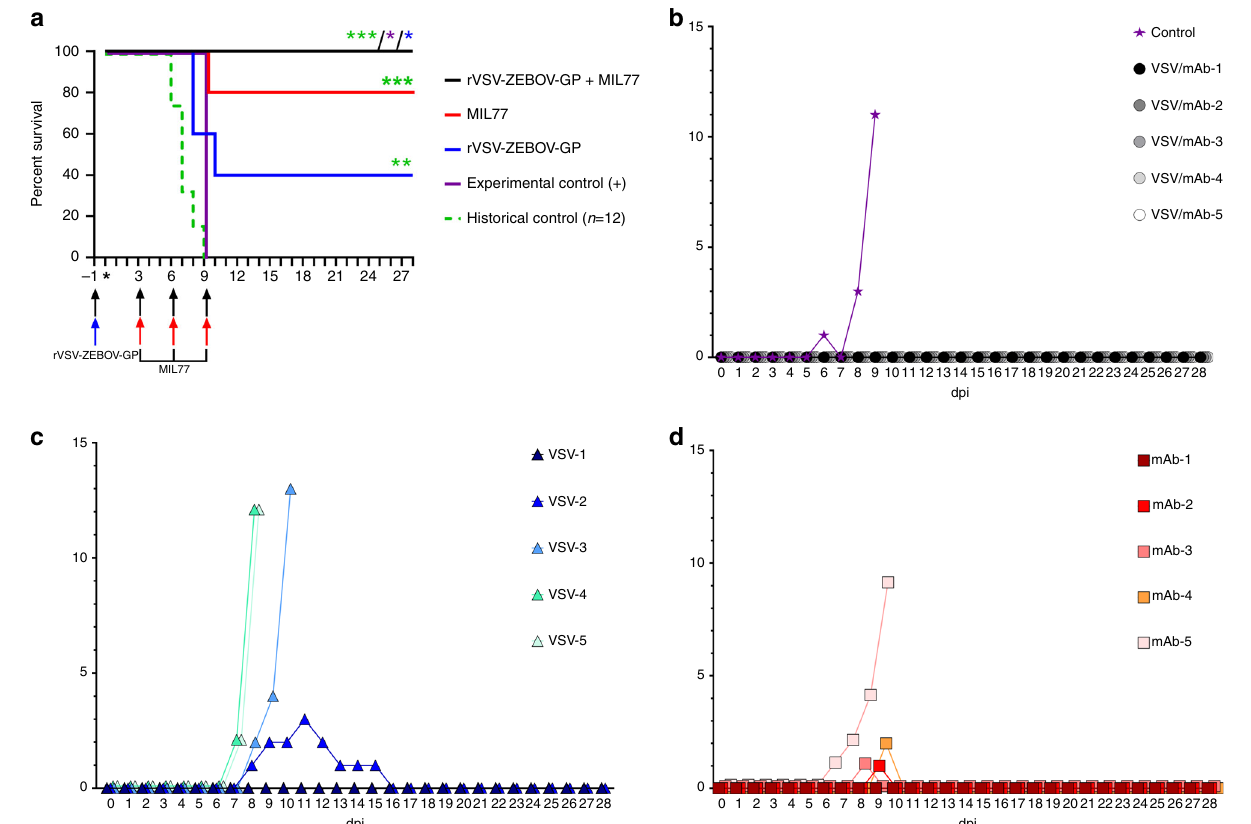
Fig. 1 Survival and clinical score outcomes. a Kaplan-Meier survival curves of vaccinated and treated animals. Animals were vaccinated/treated with rVSV-ZEBOV and/or MIL77 at the indicated day pre/post infection. n = 5 for all groups except experimental control ( n = 1). Historical control rhesus macaques infected with EBOV-Kikwit were included for statistical comparisons ( n = 12). Signi fi cance was measured using the log-rank (Mantel – Cox) test. Colored asterisks denote statistical signi fi cance to the same colored group. All p -values reported are two-tailed. p = 0.0253 for rVSV-ZEBOV + MIL77 vs. experimental control cohort; p = 0.0486 for rVSV-ZEBOV + MIL77 vs. rVSV-ZEBOV cohort; p = 0.0003 for rVSV-ZEBOV + MIL77 vs. Historical Control cohort; p = 0.0072 for rVSV-ZEBOV vs. Historical Control cohort; p = 0.0009 for MIL77 vs. Historical Control cohort; all other comparisons